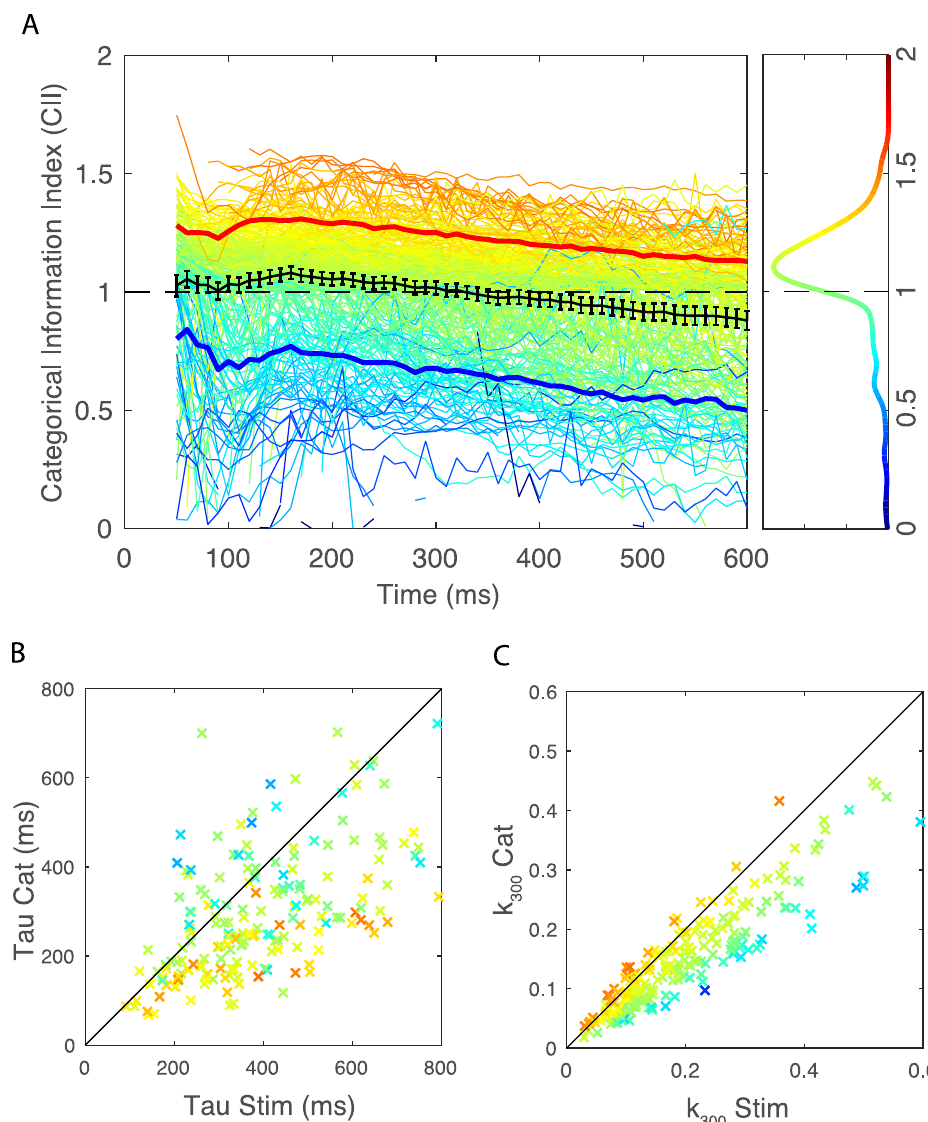
Fig 9. Categorical cumulative information index and its relationship to time constants tau and relative cumulative information estimate K 300 . As explained in Fig 8 and in the text, the cumulative information (CI) for call- type categories can be analyzed in terms of a floor or minimum value, a shared value and a ceiling or maximum value. A Value of the Categorical Information Index (CII) as a function of time for all neurons in the population. Each line color corresponds to the time average CII of the neuron obtained between 50 and 300ms. The solid red line is the average obtained for the quartile of neurons with the highest CII and the blue solid line is average obtained for the quartile of neurons with the lowest CII. Error bars on the average CII (solid bold black line) are 2 SEM. The right vertical panel shows the distribution of CIIs at 150 ms. B Scatter plot of the time constant of the exponential fit for stimuli (Stim—x axis) versus call categories (Cat—y axis). C Scatter plot of k 300 for stimuli (Stim—x axis) versus categories (Cat—y axis). Single data points in B and C are colored according to the time average CII of each neuron as in